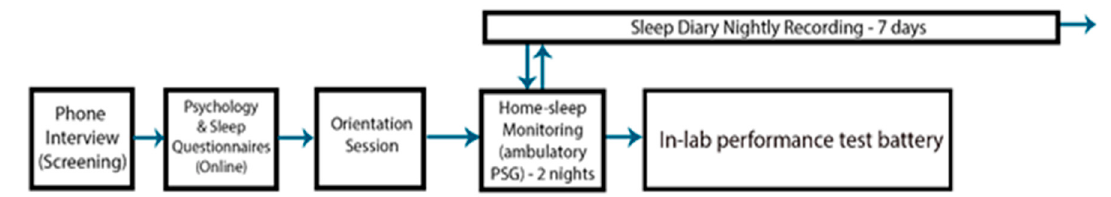
Figure 1. Overview of the progression of study protocol from recruitment to Figure 1 . Overview of the progression of study protocol from recruitment to completion.